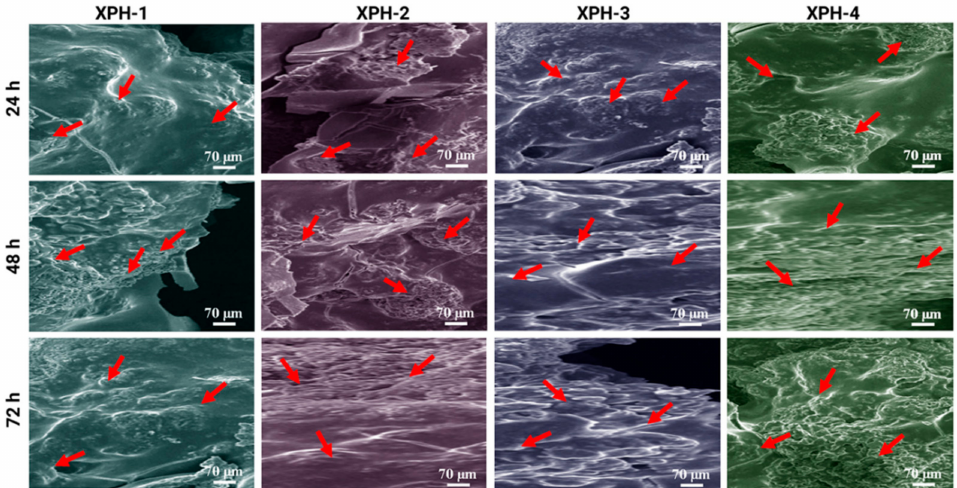
Figure 9. Presents the SEM analysis of cell culture and adherence for all hybrid nanocomposite scaffolds against MC3T3-E1 after 24, 48, and 72 h and red arrows indicate the culture and adherence of osteoblast